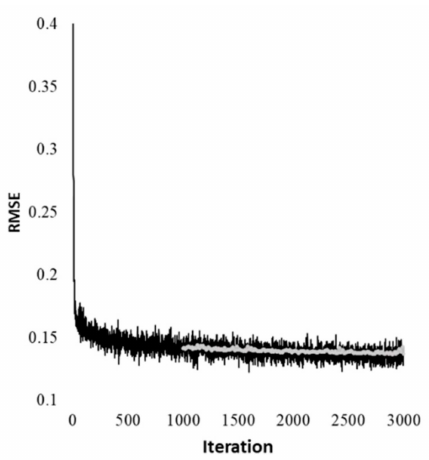
Figure 5. Convergence of the root-mean-square errors (RMSEs) during the training process. The black line indicates the training RMSE and the grey line indicates the validation RMSE.